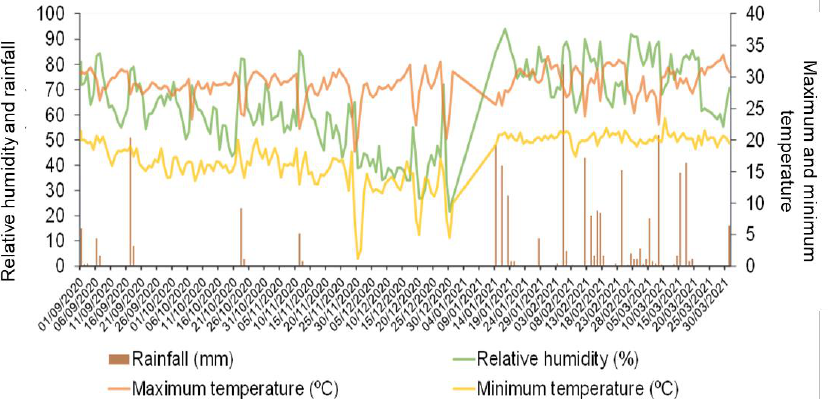
Figure 1. Maximum and minimum temperature, relative humidity, and rainfall observed during the experiment carried out with soybean submitted to post-emergence application of glyphosate isolated and associated with B. subtilis BV02. Source: Instituto Nacional de Meteorologia. Rio Verde (Brazil).